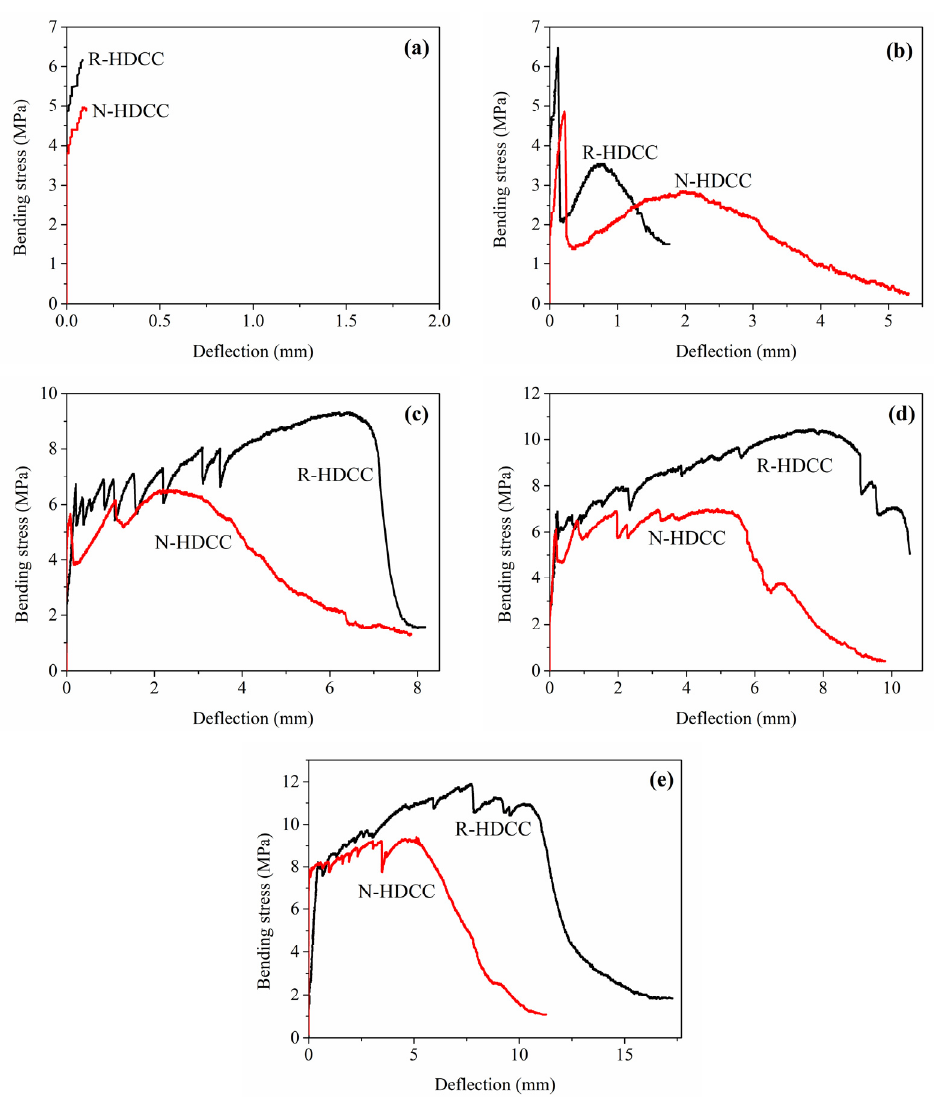
Figure 10. Bending stress versus deflection of R-HDCC and N-HDCC: ( a ) V f = 0, ( b ) V f = 0.5%, ( c ) V f = 1.0%, ( d ) V f = 1.5% and ( e ) V f = 2.0%.